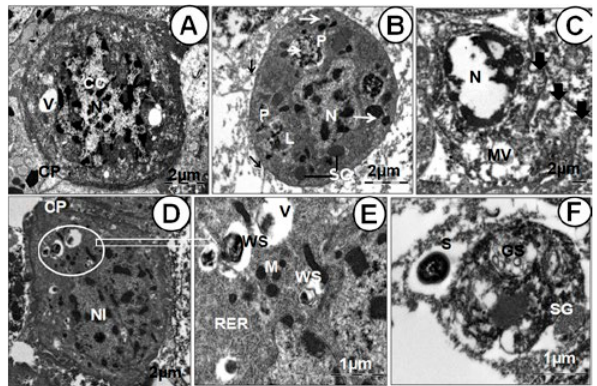
Figure 3. TEM observations on hemocytes of fifth instar larvae of B. mori showing subcellular variations after infection with N. bom- bycis : Granulocytes turn phagocytic on day 6 (A-B) showing highly deformed nucleus with condensed chromatin (CC), cellular pro- jections (CP) and few vacuoles (V) in cytoplasm. On day 10 well differentiated pseudopodia (C; black arrow heads), multivesicular body (MV) and phagosomes (P) in association with lysosomes (L) were found. On day 11, hemocytes (D - F) with dense cytoplas- mic contents, invaginated nucleus (NI) with condensed chromatin, packets of structured granules (SG), engulfed mature spores (S; white arrows), ghost spores (GS) and whirled sporoplasm (WS) in vacuoles found. Cytoplasm was with RER, mitochondria (M), and vacuoles with cellular remnants